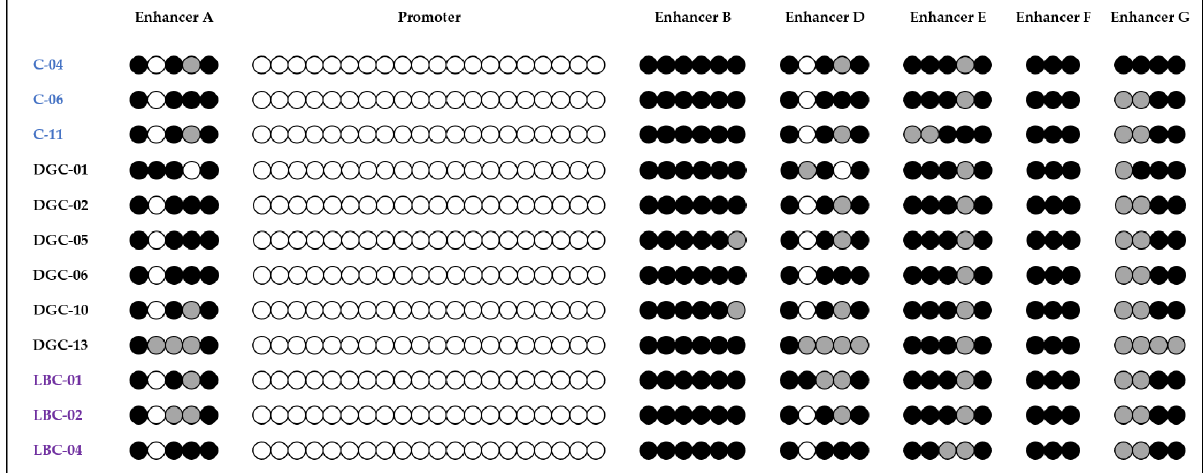
Figure 2. Methylation status of CDH1 promoter and enhancers of eight GC cell lines expressing different levels of CDH1 . non-methylated CpG site; partially methylated CpG site; fully methylated CpG site; deletion.